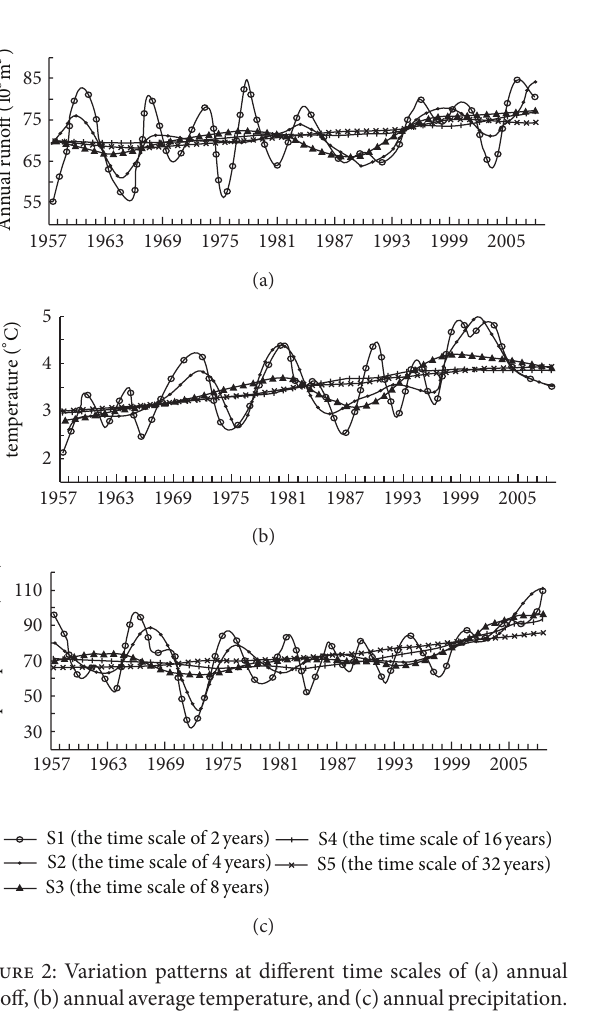
analyzed at multiple-year scales through wavelet decompo- sition on the basis of the discrete wavelet transform